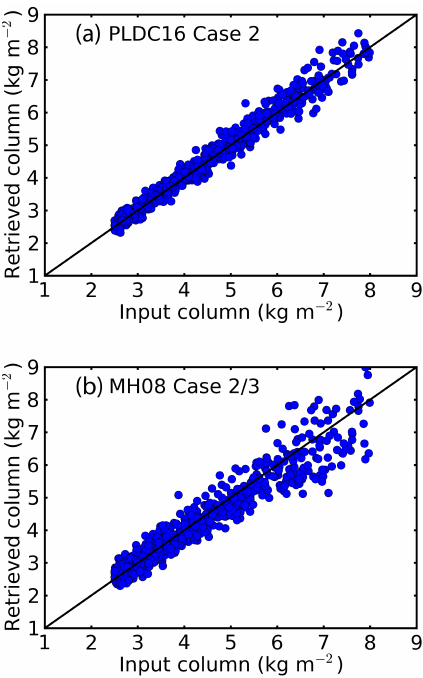
Figure 5. Comparison of the mid regime retrieval (excluding over- lap) from simulated signals against the input water vapour columns for PLDC16. The simulated brightness temperatures include Gaus- sian noise with a 0 . 5K standard deviation, and climatological aux- iliary information is used. The black line represents a perfect re-